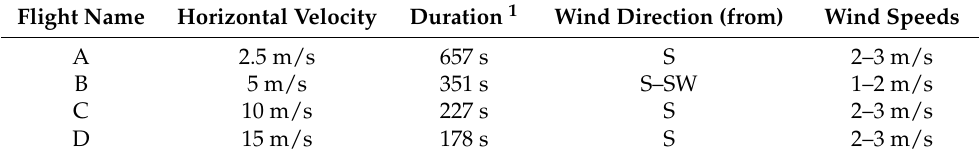
Table 3. Characteristics of each mission.